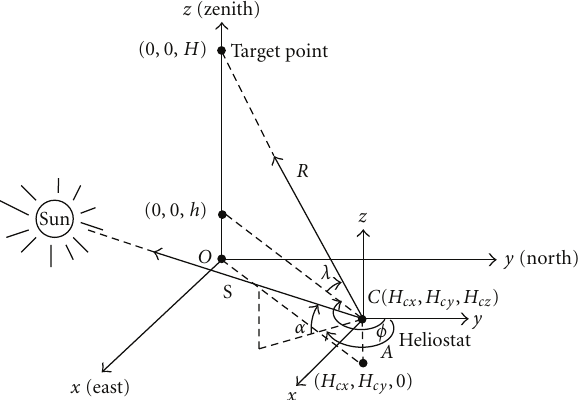
Figure 3: Coordinate defining the reflection of the sun’s ray by heliostat to a single target point in term of target angle and facing angle, incident sun’s ray in term of sun altitude angle and azimuth angle, target point, and center of the heliostat’s